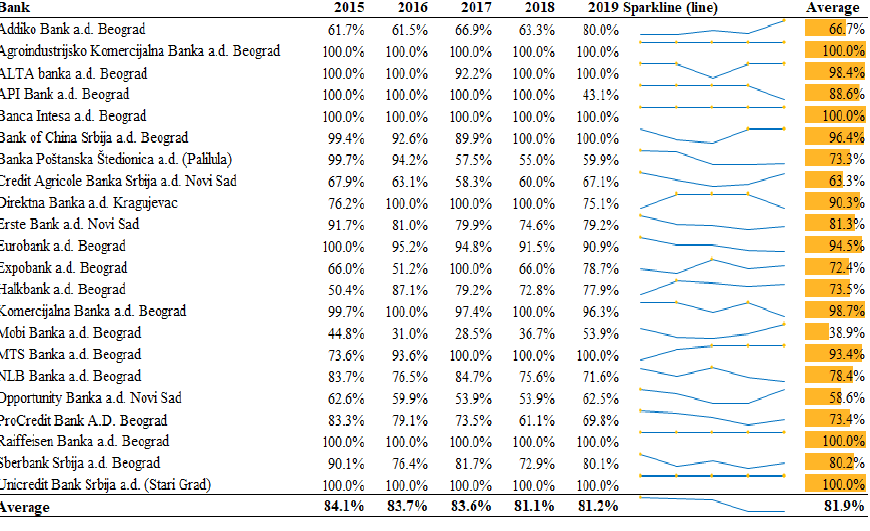
Figure 2. Serbian commercial banking efficiency results.